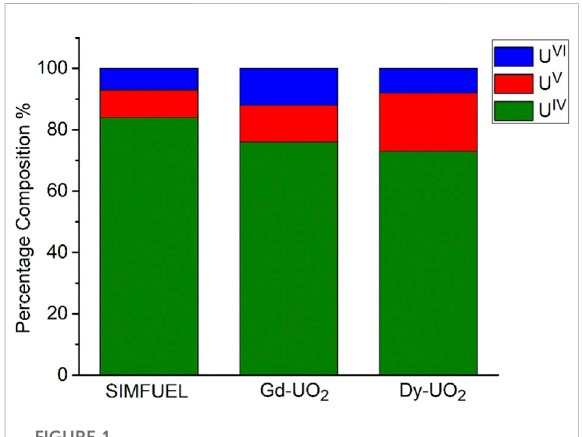
FIGURE 1 The fraction of U oxidation states on the surface of SIMFUEL, Gd-UO 2 and Dy-UO 2 after polishing and sonication.